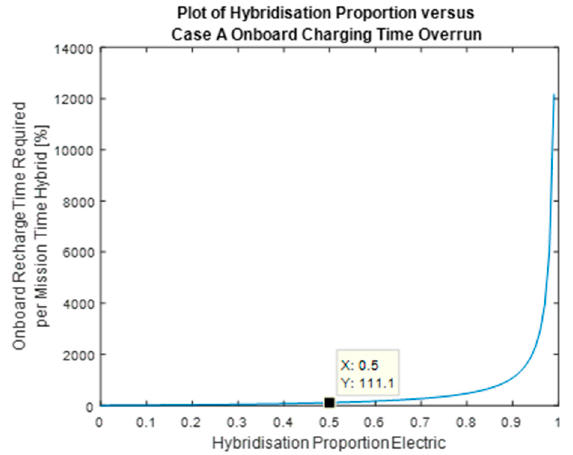
Figure 5. Hybridisation proportion vs. Case A charge time over-run; single EPS.